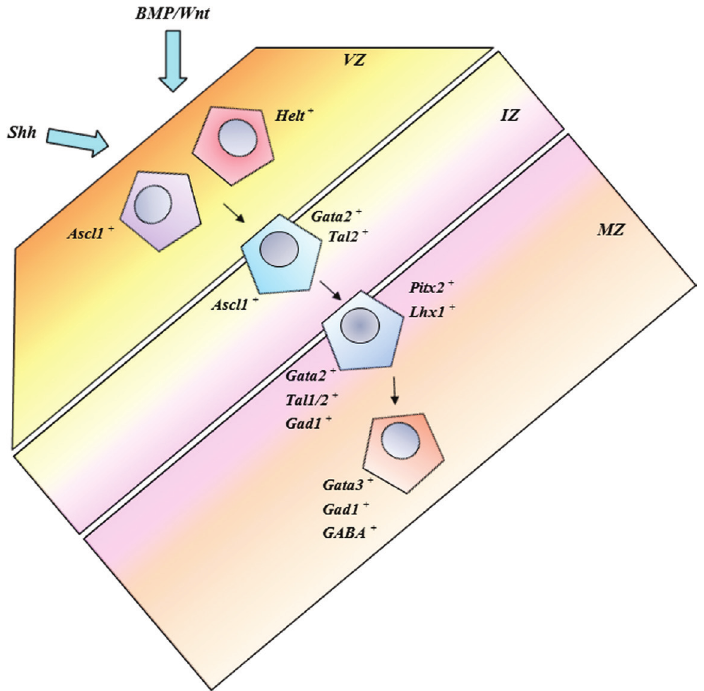
Figure 2 Overview of the molecular codes essential for generation of mesencephalic GABA neurons in relation to their specific position in the ventricular zone (VZ), intermediate zone (IZ) and mantle zone (MZ). Beginning with inductive signals, a specific cascade of molecular instruction follows in the VZ, IZ and MZ to ensure GABAergic fate specifi- cation, neurogenesis, fate maintenance and differentiation into mature GABA neuronal